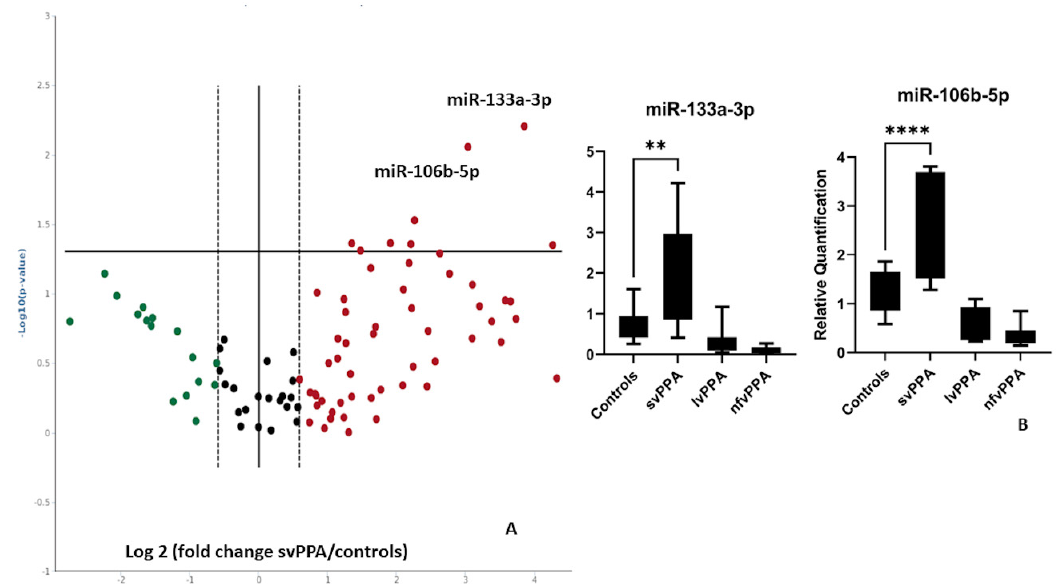
Figure 1. ( A ) Volcano plot of semantic variant PPA versus controls. Data are expressed as Log 2 (fold change) and each dot represents one miRNA. Green indicates downregulation, red upregulation and black dots represent either miRNA that are below the fold change cutoff ( B ) Box plots of miR-103a-3p and miR-106b-5p serum expression levels in svPPA patients compared to controls in the validation cohort. **** p < 0.0001, ** p = 0.0002.